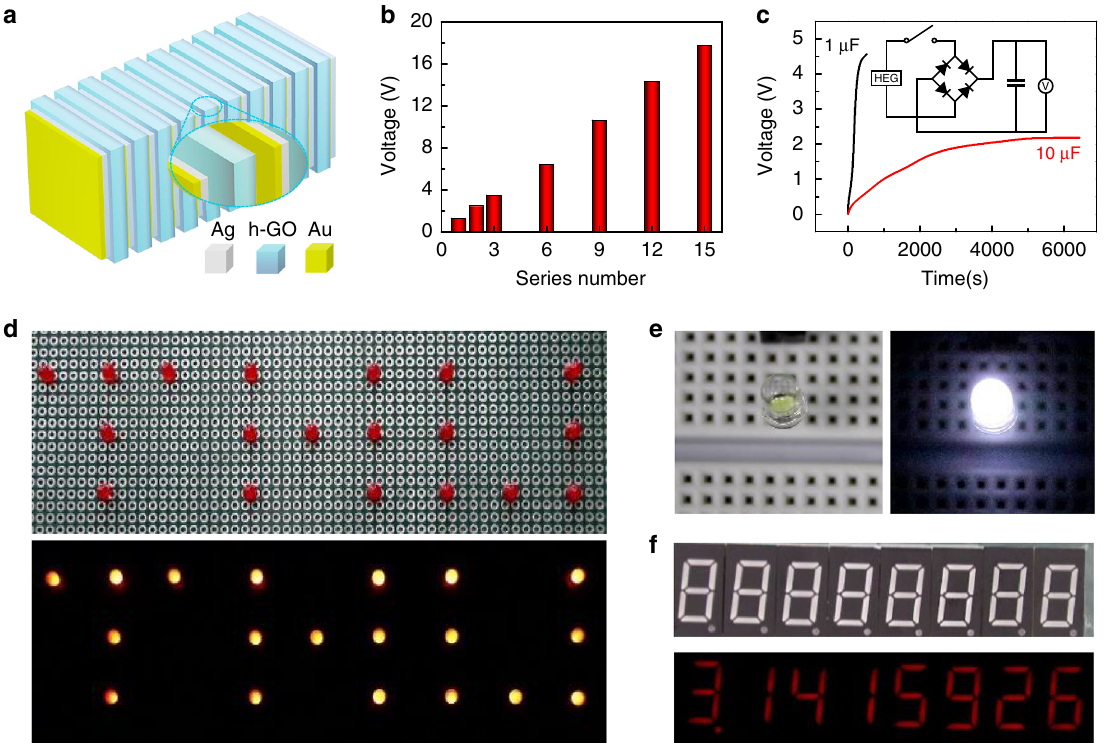
Fig. 6 Demonstration of hygroelectric generator as practical power source. a Schematic of an assembled hygroelectric generator (HEG) package in which Ag and Au electrodes are used to construct Schottky and Ohmic contacts at the two ends of the heterogenous graphene oxide (h-GO), respectively. b Voltage output of HEG package with incremental device units in series. c Voltage – time curves of commercial capacitors charging by HEG package with 12 device units. The inset is the charge storage circuit. d – f Various commercial electronics powered by the stored charge in 1 µ F capacitor ( c ), such as ( d ) a “ THU ” pattern constructed by 19 red light-emitting diodes, ( e ) white light-emitting diode with a working potential of 2.6 V, and ( f ) eight-bit digital display tube showing “ 3.1415926